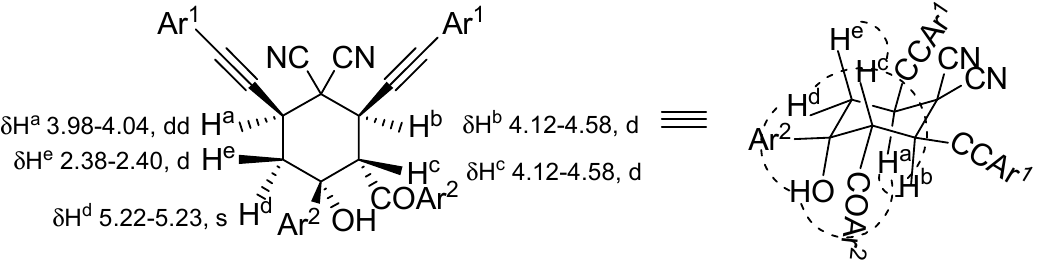
Figure 2. Selected specific signals of cyclohexane ring protons of 2 in 1 H NMR in ppm (on the left) and NOESY correlations (dashed lines) revealing the stereochemical structure of 2 (on the right).